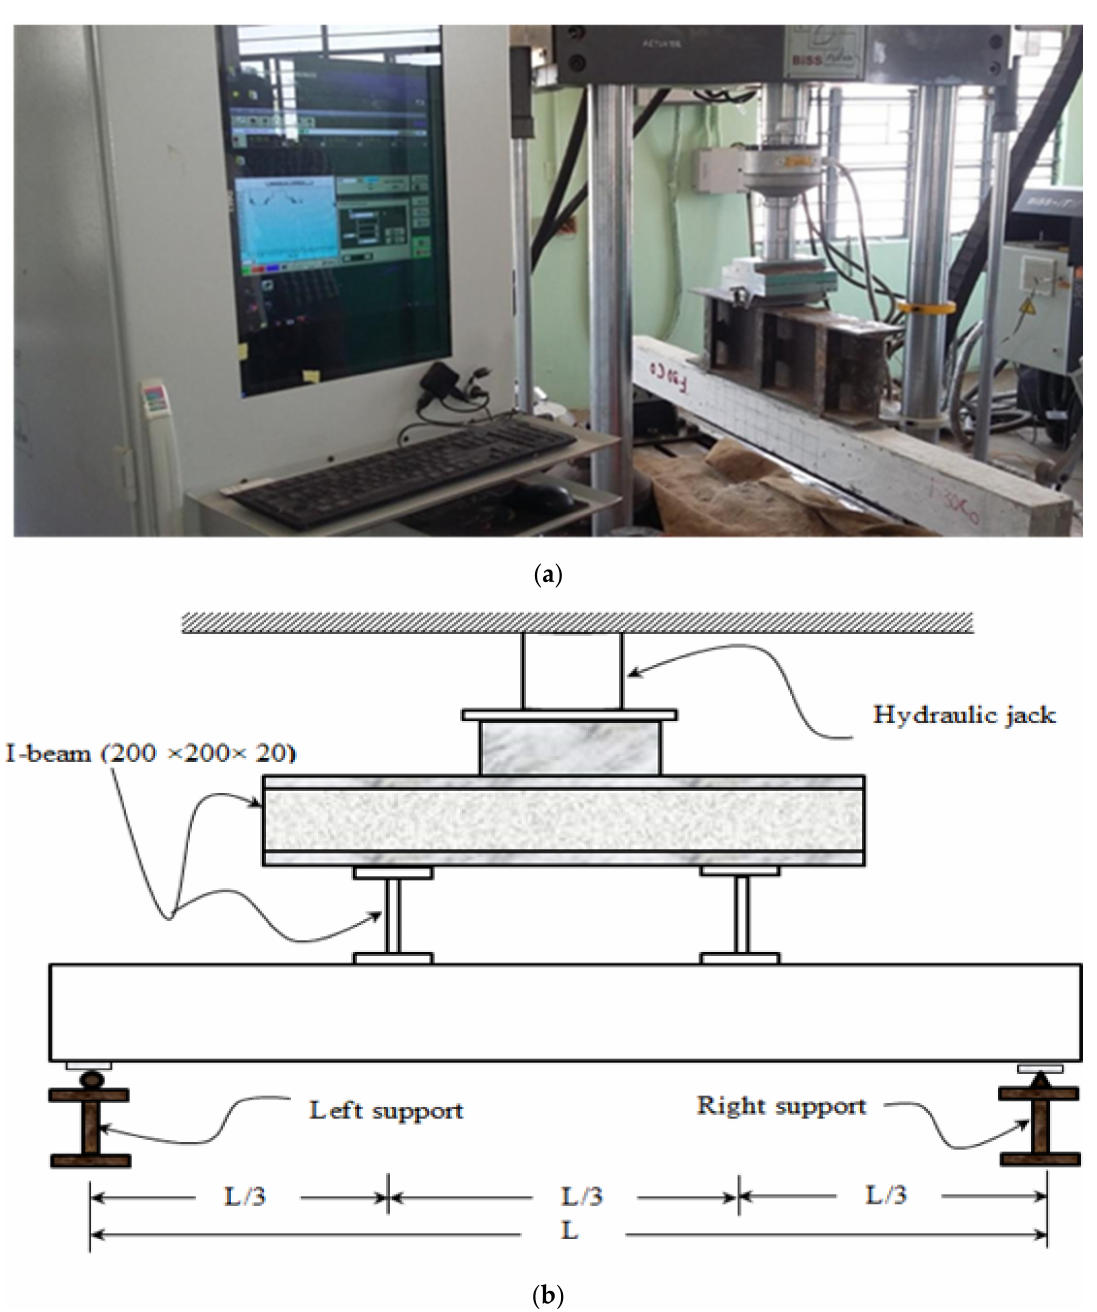
Figure 5. Typical setup of servo-hydraulic universal testing machines. ( a ) Experimental setup. ( b ) A graphic representation of the calculated beam loading